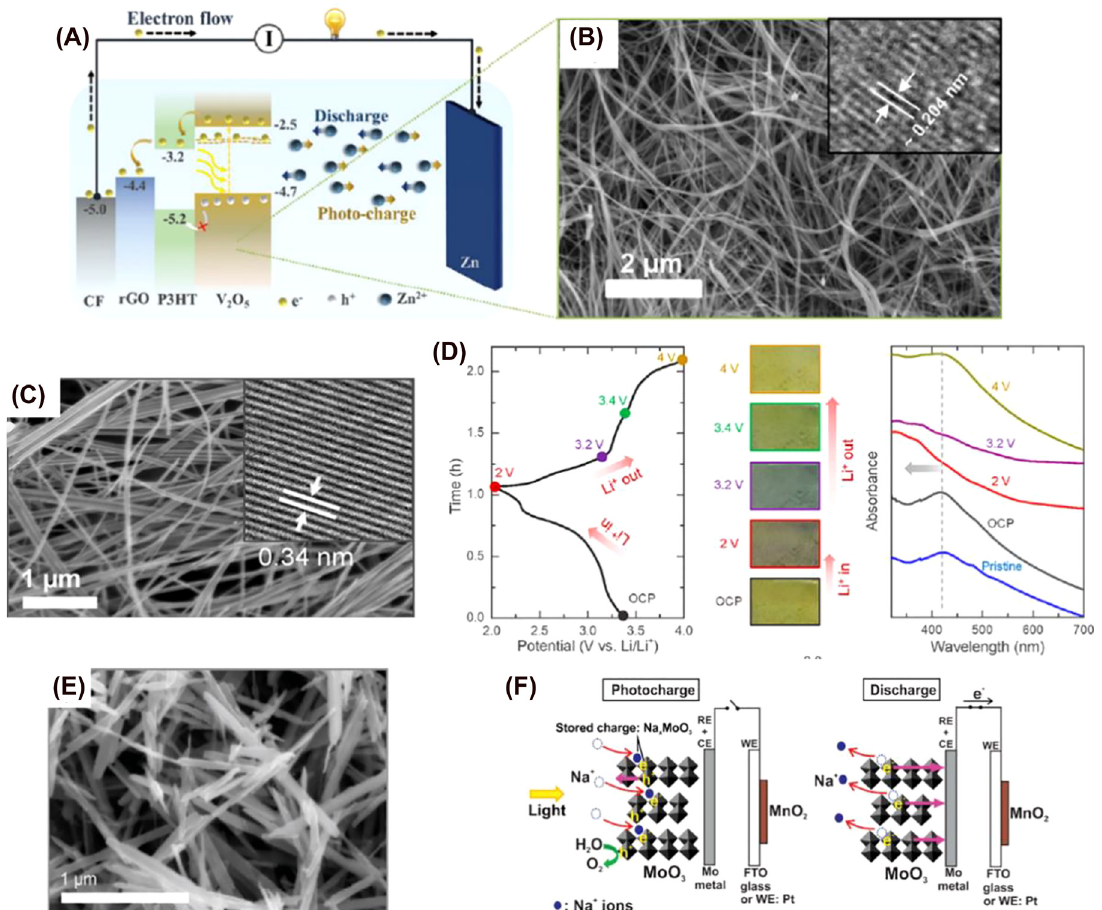
Figure 7: Structure and performance of vanadium oxides-based photoelectrodes. (A)PhotochargingmechanismofZn – airPBAT.(B)SEMimagesofV 2 O 5 nano fi bersandinsetHR-TEMimageofZn – airPBAT[69].Copyright2020, Royal Society of Chemistry. (C) SEM image of V 2 O 5 nano fi bers andinset HR-TEM image of Li-ionPBAT. (D) Initial discharge – charge curve using an optical-cell, images showingthe change in color as a function of the SOC, and ex situ absorbance spectra of the PE at different SOC of V 2 O 5 nano fi bers in Li-ion PBAT [211]. Copyright 2021, American Society of Chemistry. (E) SEM image of VO 2 nanorods [215]. Copyright 2021, Royal Society of Chemistry. (F) Photocharging and discharging mechanisms of Na-ion PBAT [216]. Copyright 2017, John Wiley and